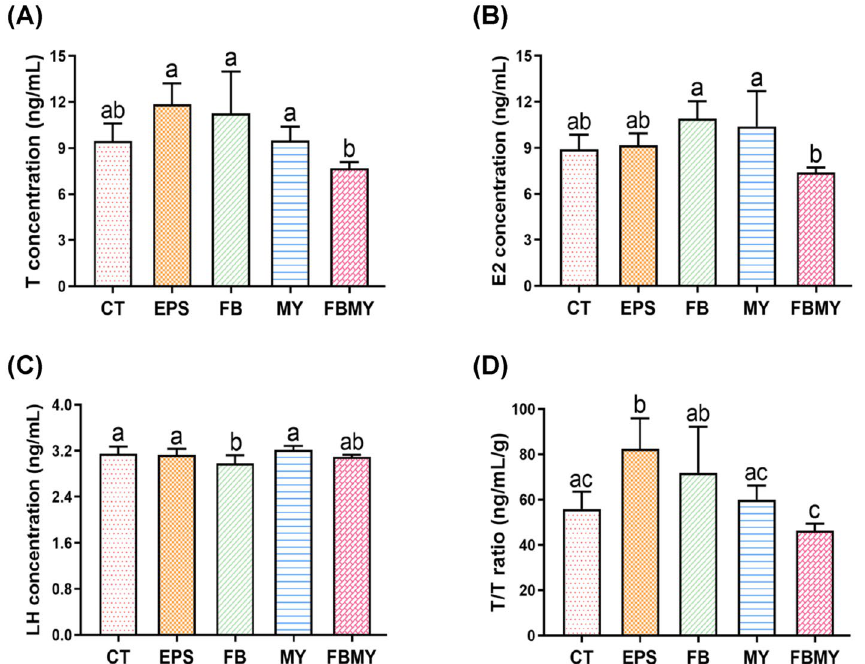
Figure 5. Effects of C. militaris fermentation products on serum sex hormone levels in different indicated groups. T concentration (A) , E2 concentration (B) , LH concentration (C) , and calculated T/T ratio (D) were shown. Values are presented as means ± SD (n = 5 for all test groups). Panels marked with different lowercase letters are significantly different ( p <